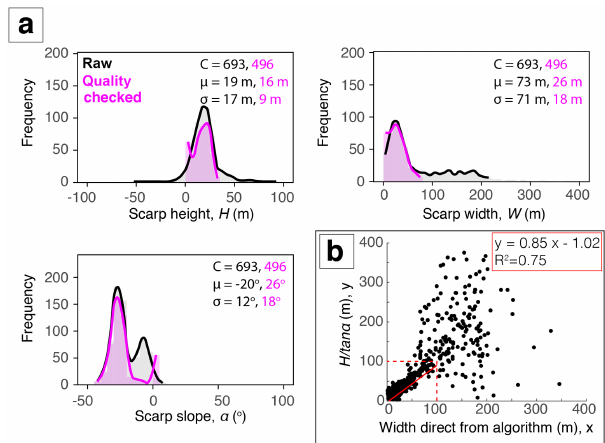
Figure 9. (a) Histogram of the estimated scarp parameters for the Bilila–Mtakataka fault for all (raw) algorithm estimates (black) and post-quality-checked (pink) results. (b) A comparison between the scarp width obtained directly from the algorithm and the scarp width calculated using the algorithm’s scarp height and slope val- ues ( W c = H c / tan α c ). A linear regression is applied where width is less than